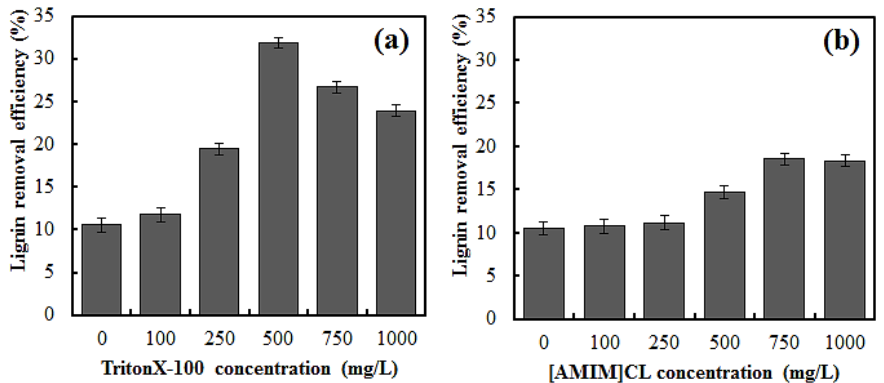
Figure 1. Effect of IL and surfactant concentrations on biological lignin removal efficiency. ( a ) [AMIM]Cl concentrations and ( b ) TritonX-100 concentrations.